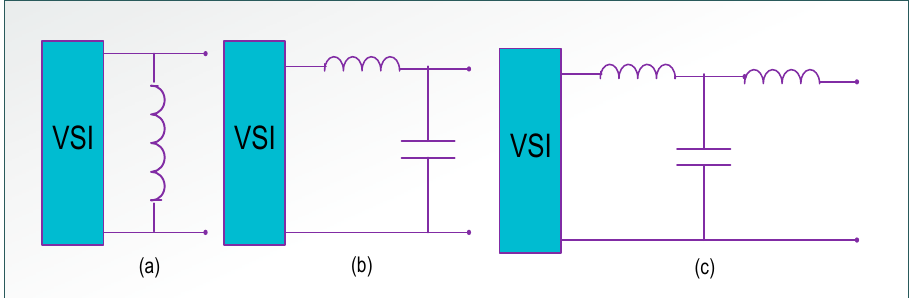
Figure 9. Basic filter topologies: ( a ) L filter, ( b ) LC filter and ( c ) LCL filter. Modeling of grid interfaced inverter with LCL